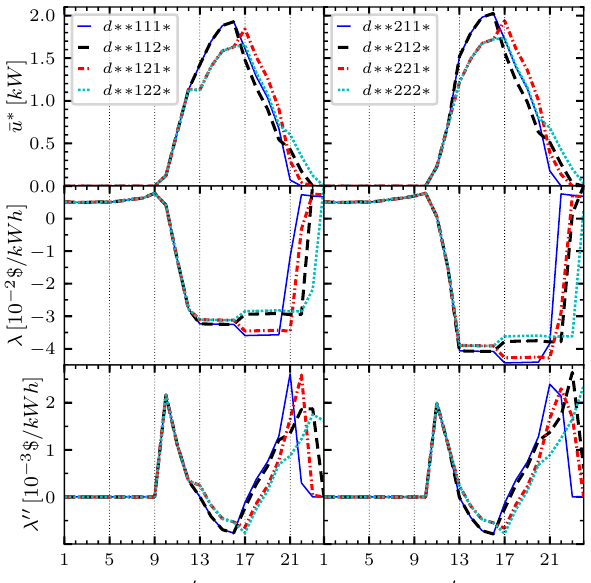
Figure 5. Aggregate control u ∗ at the social optimum, taxes/incentives λ obtained as a direct solution of the KKT equations, and tuned taxes/incentives λ (cid:48)(cid:48) for eight different scenarios. In the legend, asterisks “ ∗ ” correspond to the intervals I ˜ t during which the solution is not affected by the non-PEV demand